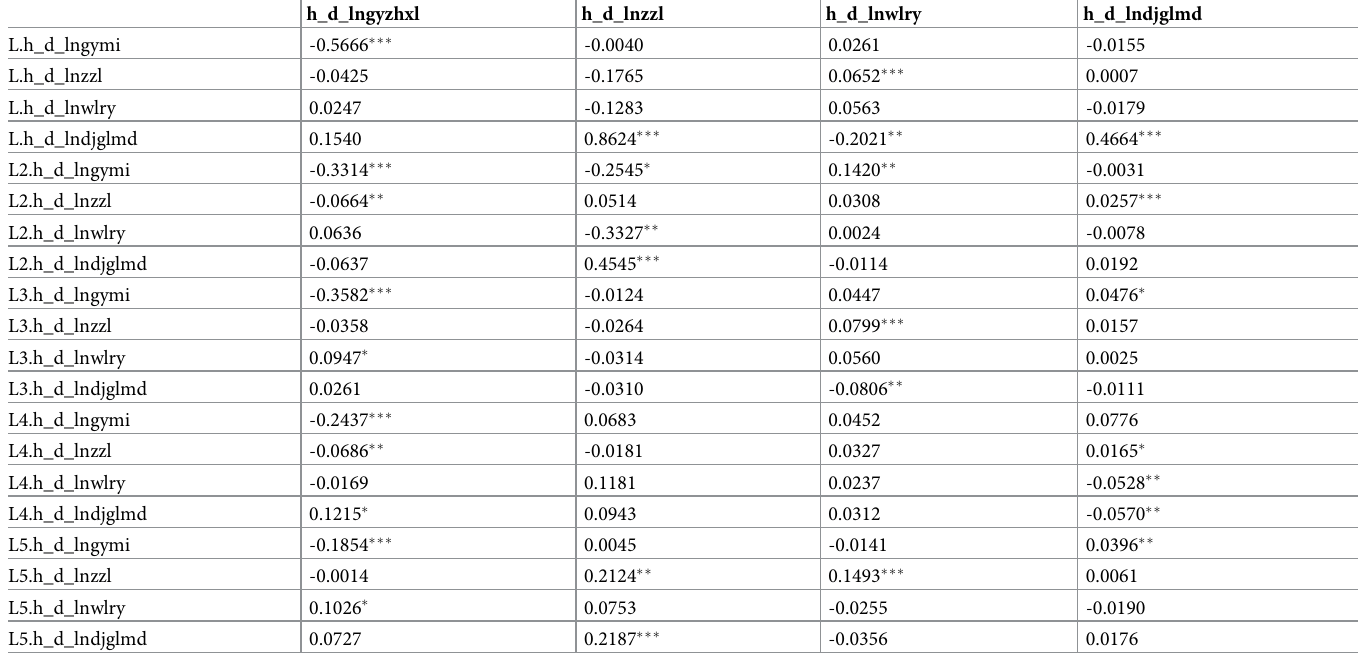
Table 15. GMM estimation results of PVAR model for logistics industry and manufacturing